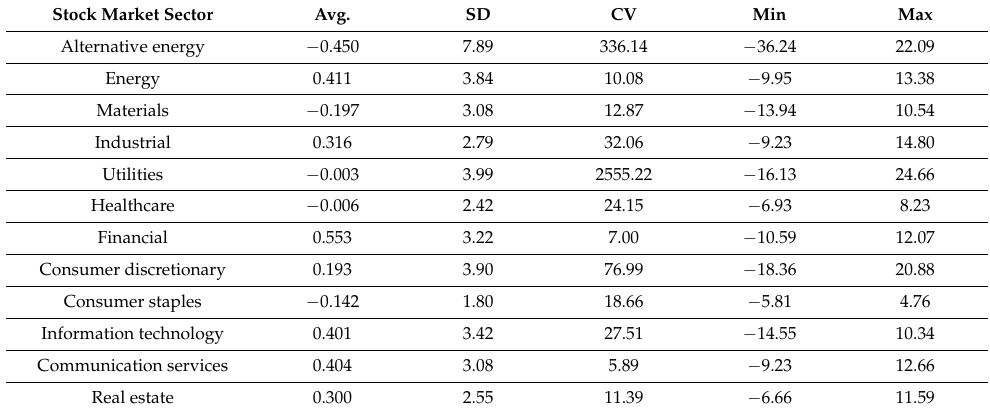
Table 4. Descriptive statistics for average weekly rates of return of alternative energy and main stock market sectors: based on the performance of the top five companies in January–September 2021. Stock Market Sector